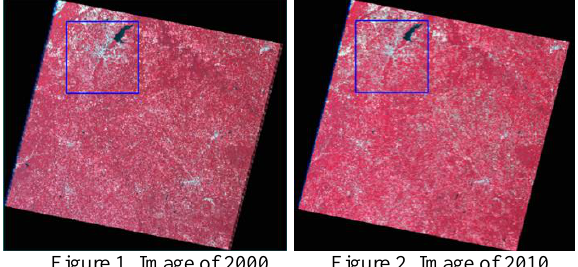
The Landsat images are pre-processed with geometric correction and radiometric correction. After Landsat images were pre-processed, we subset a study area whose area is 1024 by1024 pixel and downtown of Jackson city is included in this area. To conduct the change detection method of pixel-based and object-oriented, we chose dNDVI and CV as feature to extract change region from the image in this paper. 220 change sample units (3by 3 Landsat pixel kernel) and 190 unchanged sample units were randomly drawn from study area and used to assess the quality of the change detection results in the error